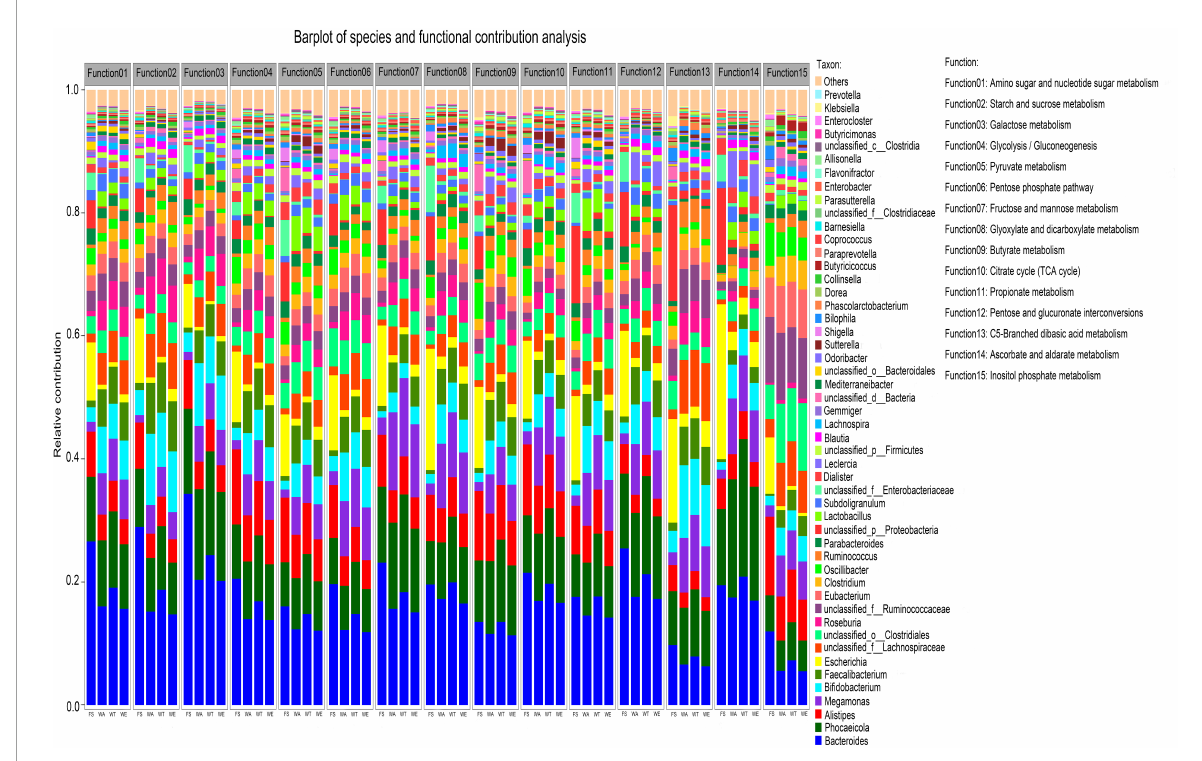
FIGURE5 Relative contributions of different taxa to metabolic pathways at the genus level. Function1 to Function15 are the functional name of the level 3 KEGG pathway, and the ordinate is the corresponding genus-level contributing